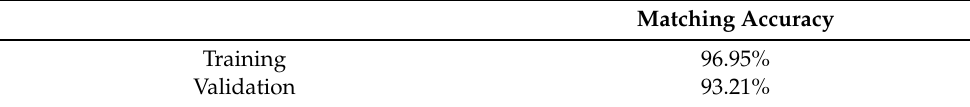
Table 5. Wheel matching network performance.